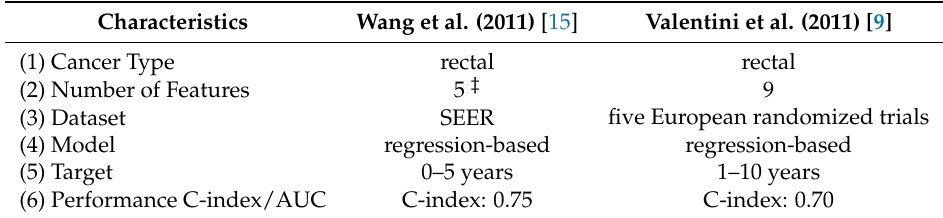
Table 2. Characteristics of models for rectal cancer survivability